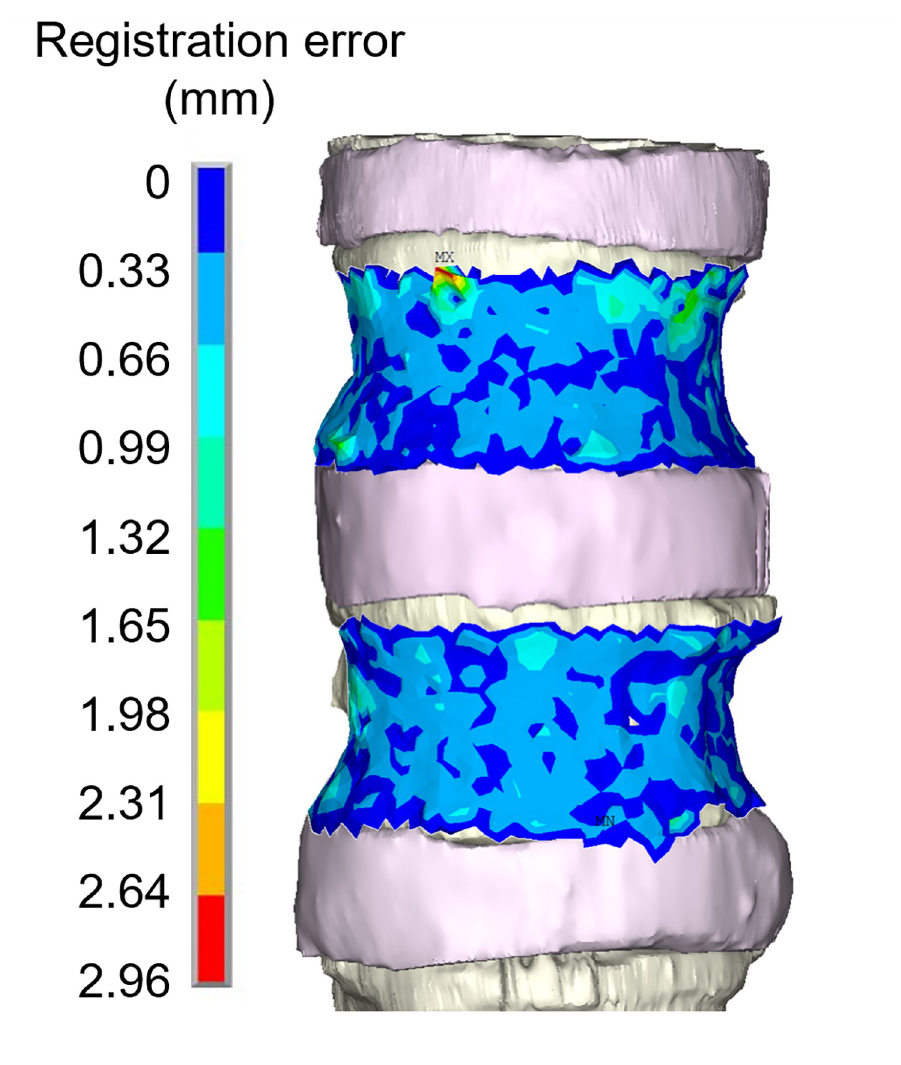
Fig 3. Graphical representation of spatial distribution of the registration error. Spatial distribution of the registration error of DIC points on the vertebral surfaces of the FE model.